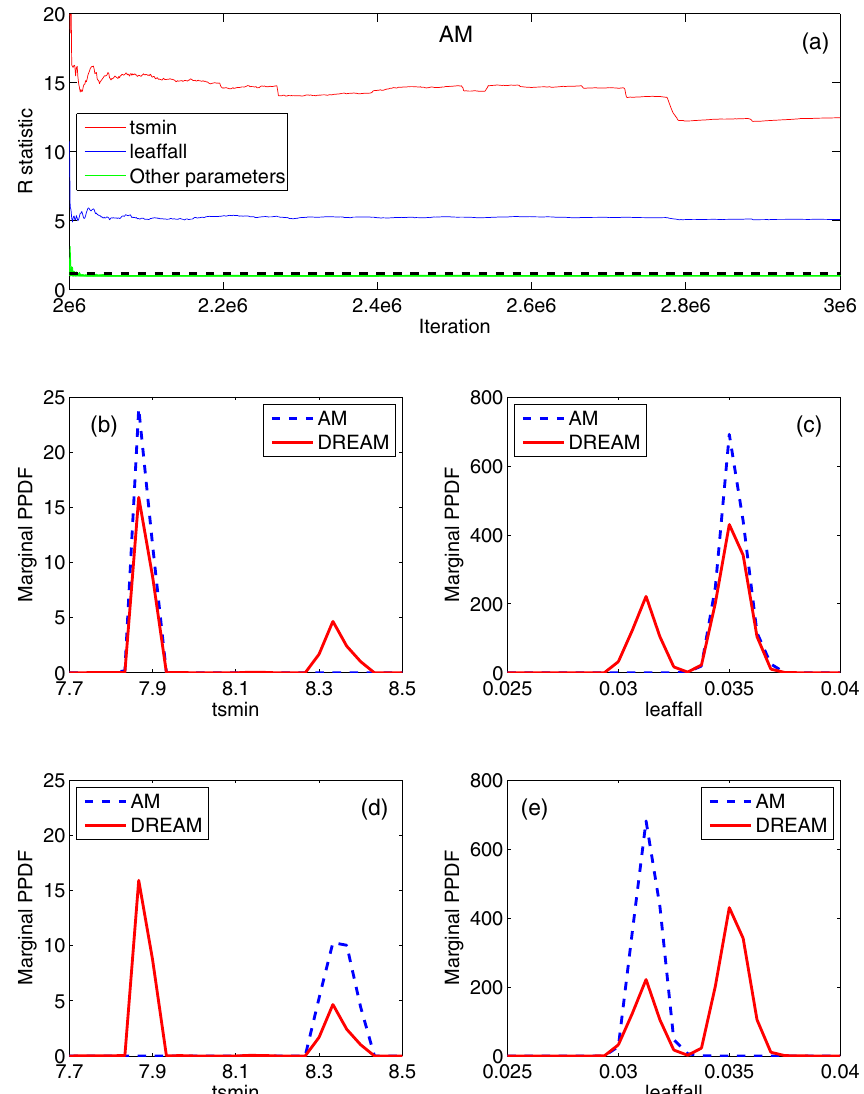
Figure 9. Results of two independent chains of AM with the initial covariance matrix constructed using the converged DREAM samples. The ˆ R statistic in (a) suggests that different AM chains converged to different tsmin and leaffall values. One chain captures (b) the left mode of tsmin and (c) the corresponding right mode of leaffall , and the other chain identifies (d) the right mode of tsmin and (e) the corresponding left mode of leaffall . No single AM chain can capture all the modes of the two parameters within a reasonable number of MCMC